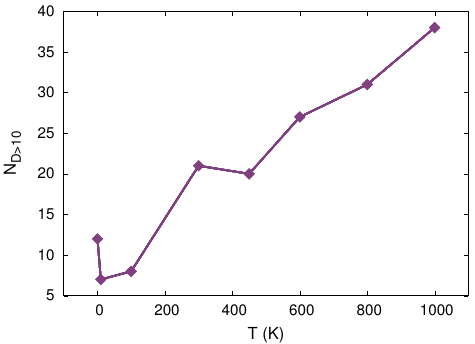
Figure 10. Number of disappearing clusters as a function of